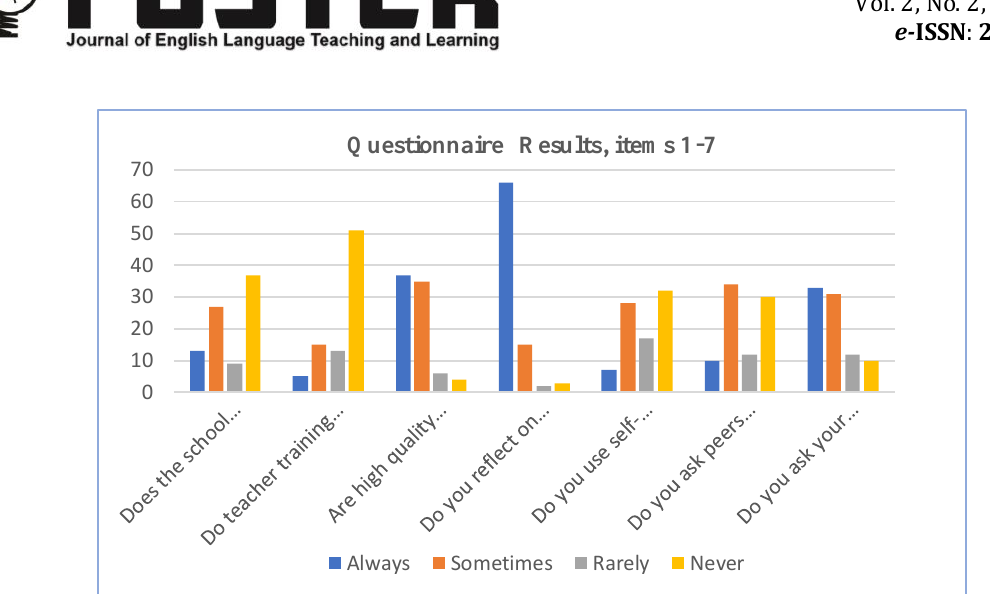
Figure 1. Teachers’ respo nses about teacher self-evaluation (questionnaire items 1-7)